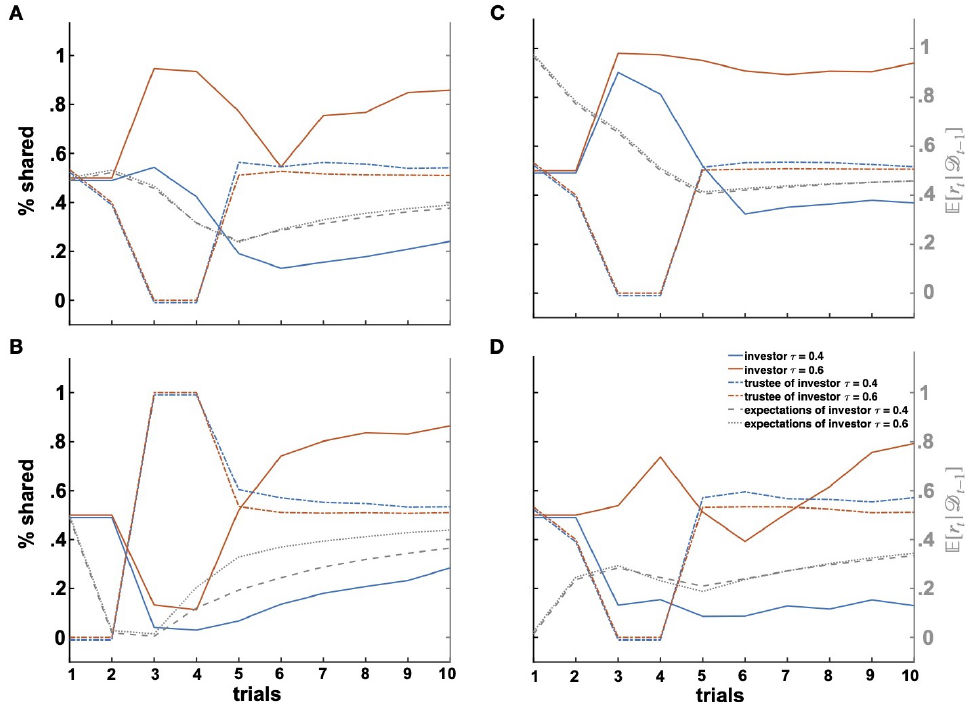
Figure 5. Breach and repair of trust. Effects of breach of trust (Trials 3–4) with trustful (red line and τ = 0.6) and distrustful (blue line and τ = 0.4) investors ( A ). Repair of trust ( B ) after initial uncooperativeness (Trials 1–2). Effects of positive ( C ) and negative ( D ) expectations on repair of